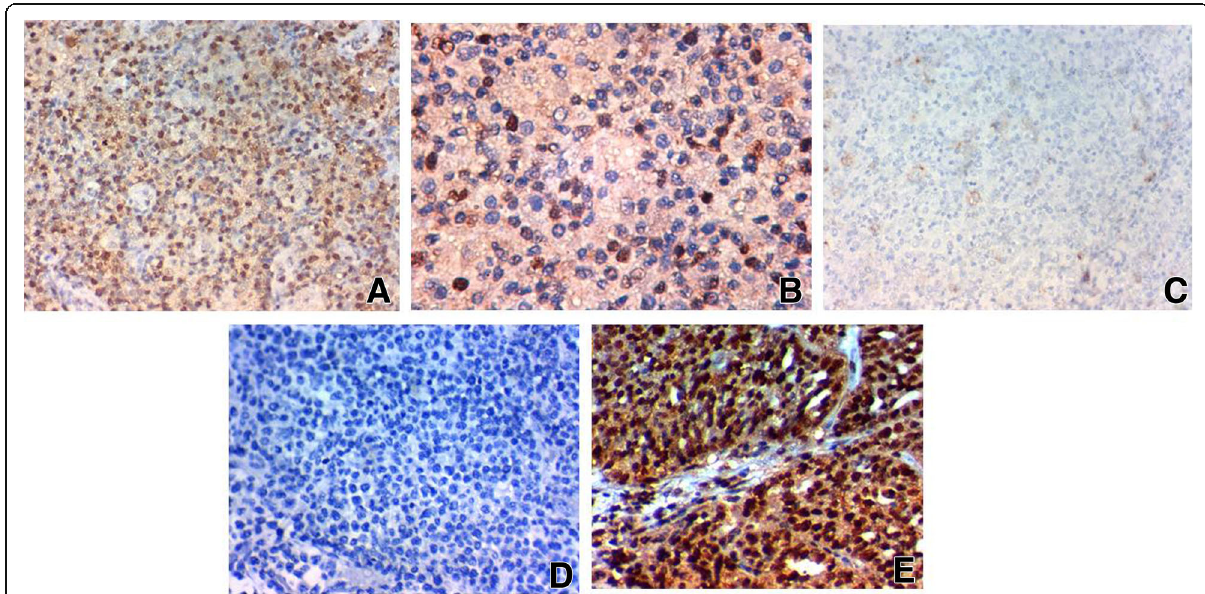
Fig. 3 Immunohistochemical expression of Signal transducer and activator of transcription-3 (STAT-3); ( a ) High nuclear STAT-3 expression in DLBCL stage IV × 400 ( b ) High nuclear STAT-3 expression in DLBCL stage III × 400 ( c ) negative nuclear STAT-3 expression in DLBCL stage I × 400 ( d ) positive nuclear STAT-3 expression in sections from invasive duct carcinoma of the breast as appositive control of the marker × 400 ( e ) Negative control by replacement of the primary anti- STAT-3 antibody by phosphate buffered saline ×